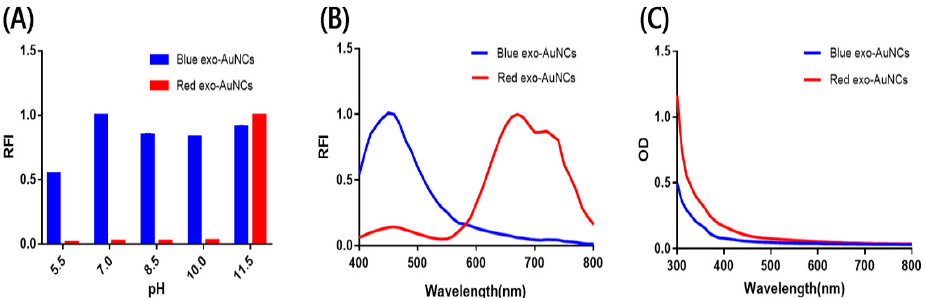
Figure 1. Synthesis of exo-gold nanoclusters (AuNCs) . ( A ) The effect of pH on the formation of blue- and red-emitting exo-AuNCs. The relative fluorescence intensity (RFI) was calculated by dividing the fluorescence intensity at different pH values (5.5, 7.0, 8.5, 10.0, and 11.5) by the maximum fluorescence intensity at emission wavelengths of 460 nm (blue) and 670 nm (red); both blue- and red-emitting exo-AuNCs were excited at 360 nm. ( B ) Relative fluorescence emission spectra of blue- and red-emitting exo-AuNCs at an excitation wavelength of 360 nm. The RFI was calculated by dividing the fluorescence intensity at different wavelengths by the maximum fluorescence intensity. ( C ) Ultraviolet–visible (UV-Vis) absorbance spectra of exo-AuNCs. The OD in Y-axis indicates the optical density. All experiments were performed in triplicate, and the data are displayed as the mean ± SD.